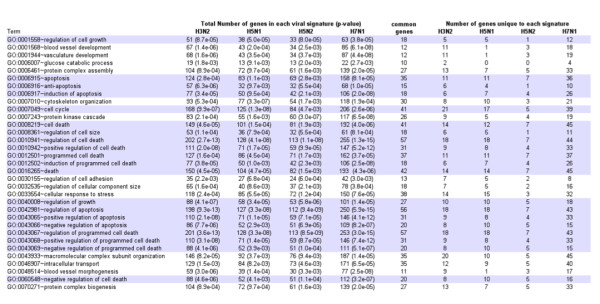
Significantly enriched GO Biological Processes (p-value < 0.01) common to H3N2, H5N1, H5N2 and H7N1 specific signatures. Terms related to the p53 pathway are highlighted in grey.